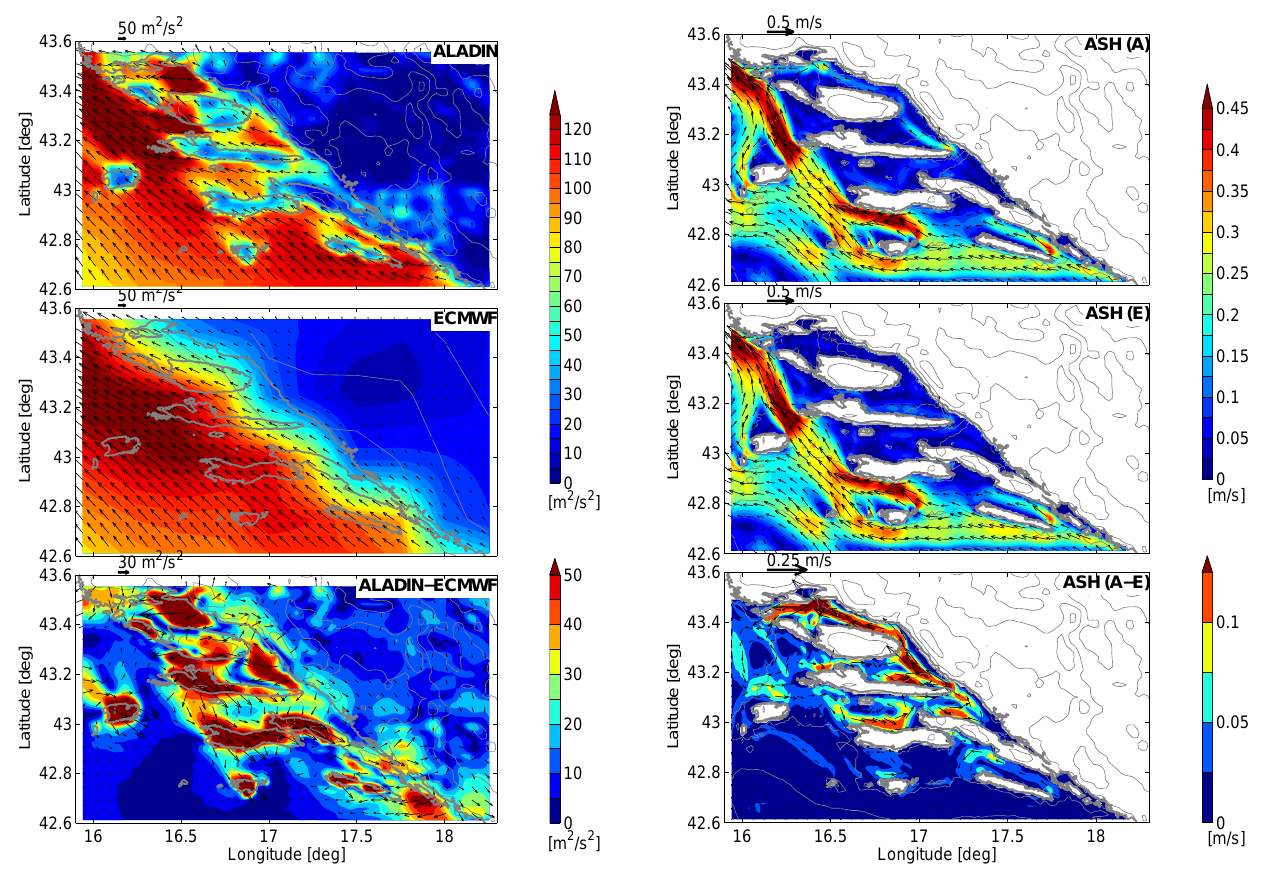
Fig. 7. Mean ALADIN (top panel) and ECMWF (center panel) modeled pseudo-stress for the Sirocco episode (Table 1). The bot- tom panel shows the difference between these two. Topography contours, as seen from the models, and shore lines are indicated by thin and thick gray lines, respectively.